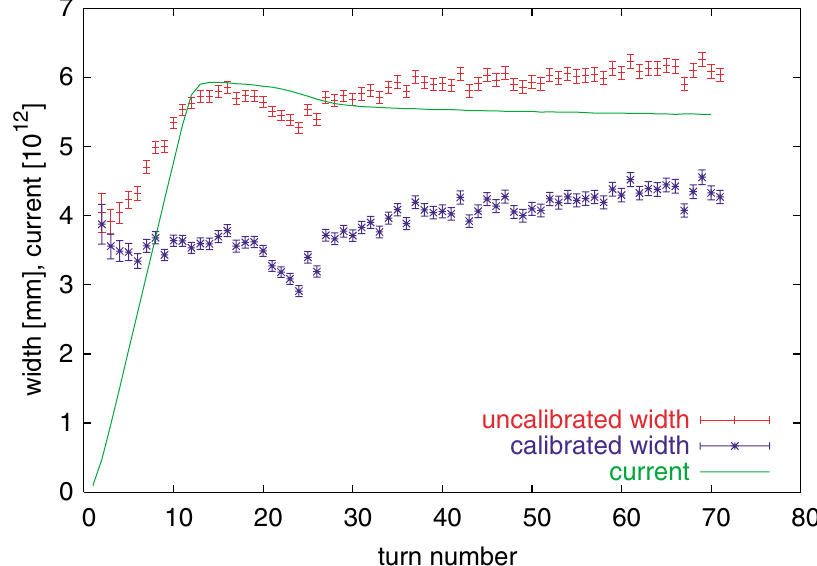
FIG. 7. (Color) Horizontal beamwidth in the booster, measured by the IPM as a function of time, measured in booster turns ( 2 : 2 (cid:8) s ), at injection. Both the calibrated (blue) and uncalibrated (red) widths are shown. Also shown (green curve) is the beam current in the machine, in units of 10 12 protons = turn, versus time.